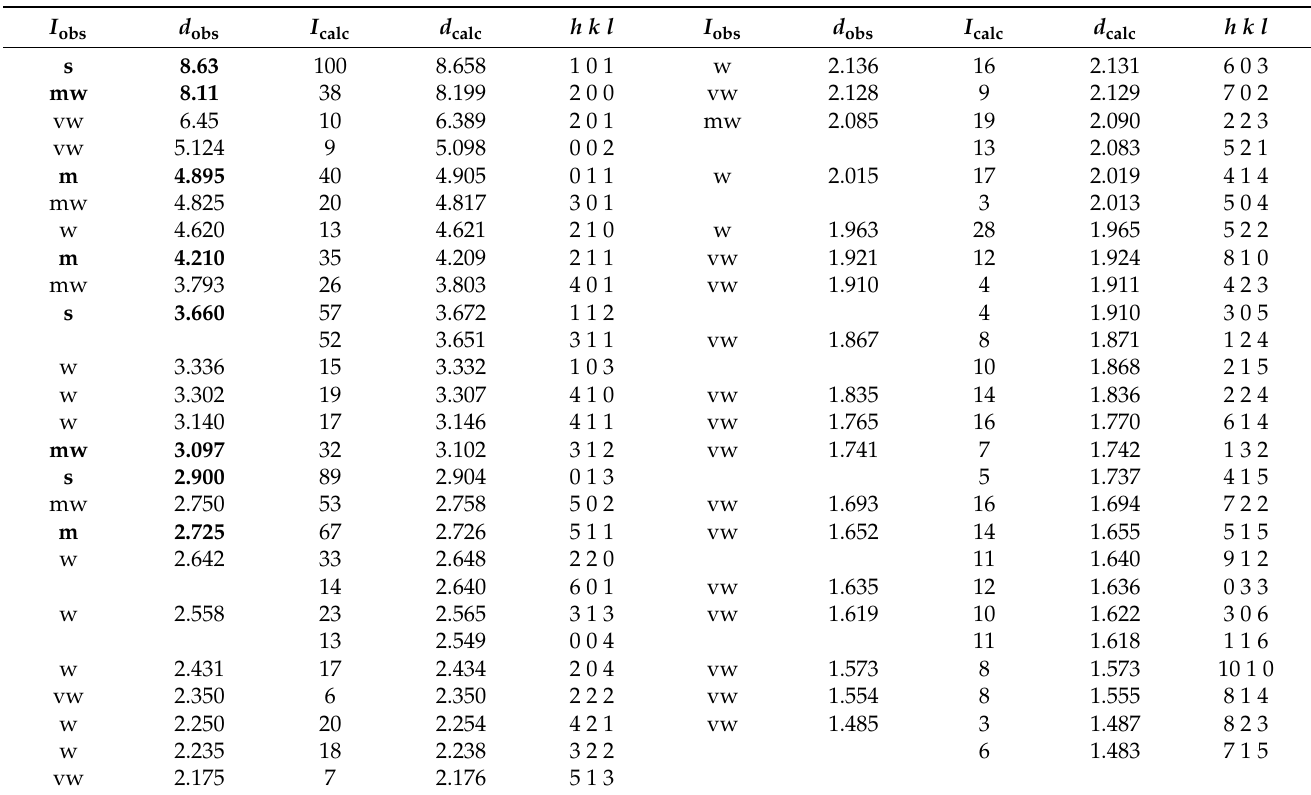
Table 3. X-ray powder diffraction data ( d in Å) for zoisite-(Pb). Intensity and d hkl were calcu- lated using the software CrystalDiffract (CrystalMaker Software Ltd. Kidlington, UK) on the ba- sis of the structural model given in Table 5. Only the reflections with I calc > 10 are given, if not observed. The eight strongest reflections are given in bold. Intensities were visually estimated: s = strong; ms = medium–strong; m = medium; mw = medium–weak; w = weak; vw = very